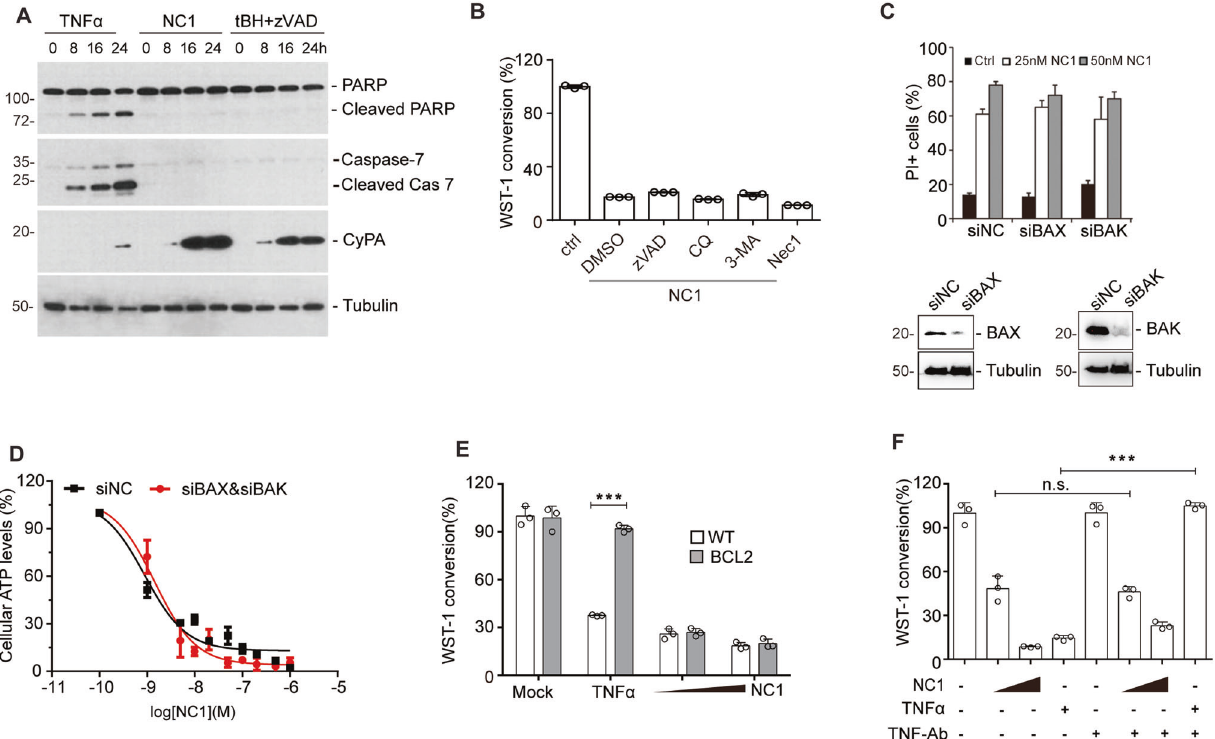
Fig. 3 NC1 elicits a non-apoptotic cell death independent of TNFR1 pathway. A Lack of caspase activation by NC1. MCF-7 cells were lysed at the indicated time after the addition of TNF α or NC1, and lysates were subjected to immunoblotting for the detection of poly (ADP-ribose) polymerase 1 (PARP1) and proteolytically mature caspase-7. Supernatant was collected to detect the release of Cyclophilin A (CyPA) into the extracellular medium. Tubulin was detected to ensure equal lane loading. B MCF-7 cells were treated with NC1 and(or) apoptosis inhibitor z- VAD-fmk, necrosis inhibitor Necrostain-1 (Nec1), autophagy inhibitor chloroquine (CQ) and 3-MA. Cell viability was determined by measuring cellular ATP levels. The data are represented as the mean ± SD of triplicate wells. C MCF-7 cells were transfected with siRNA specially against BAX or BAK for 48 h, then subjected to 25 nM NC1 for 12 h to detect cellular viability. D MCF-7 cells were transfected with siRNA speci fi c for BAX and BAK for 48 h, then subjected to the indicated concentration of NC1 for 12 h before detecting cellular viability. E Failure of BCL2 to inhibit NC1-induced cell killing. Parental or BCL2-overexpressing MCF-7 cells were exposed for 24 h to TNF α or NC1, and WST1 conversion was assessed to estimate cellular viability. F Putative contribution of TNF α to NC1-induced cell killing. MCF-7 cells were treated for 24 h with the indicated combinations of NC1, TNF α and TNF α neutralization antibody (TNF-Ab), followed by measurement of cellular ATP level. Asterisks indicate signi fi cance between the two groups indicated (* p < 0.05; ** p < 0.01, ** p <